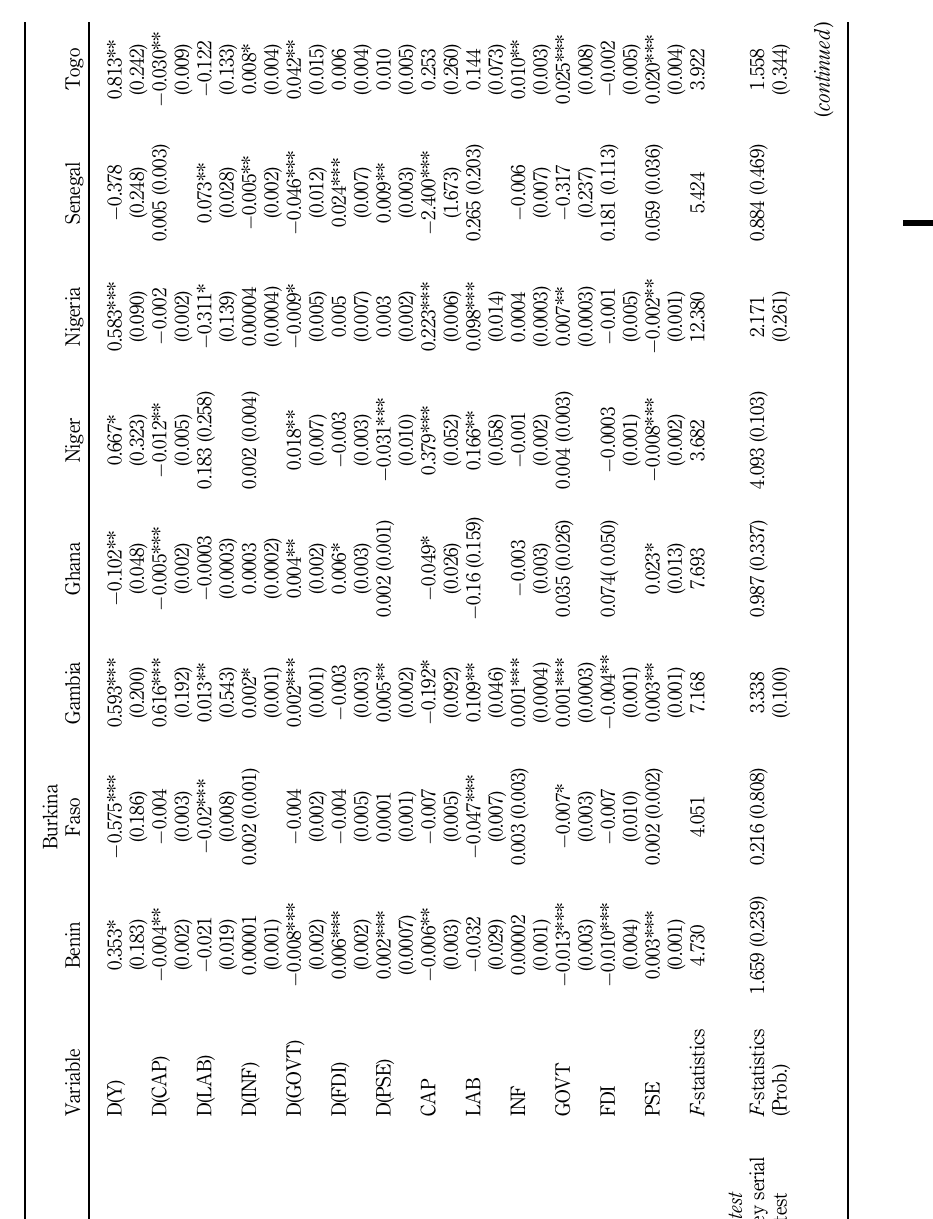
Table 2. Models with